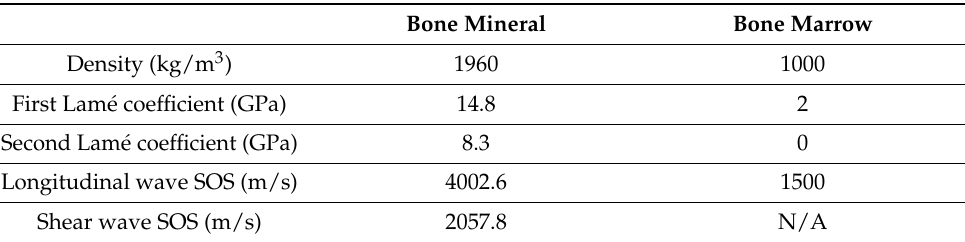
Figure 1. The ultrasound (US) and photoacoustic (PA) 2D simulation system. ( a ) Flow chart of the US and PA 2D simulation process. ( b ) Schematic diagram of the US mode. ( c ) Schematic diagram of the PA mode. Table 1. Properties of the related